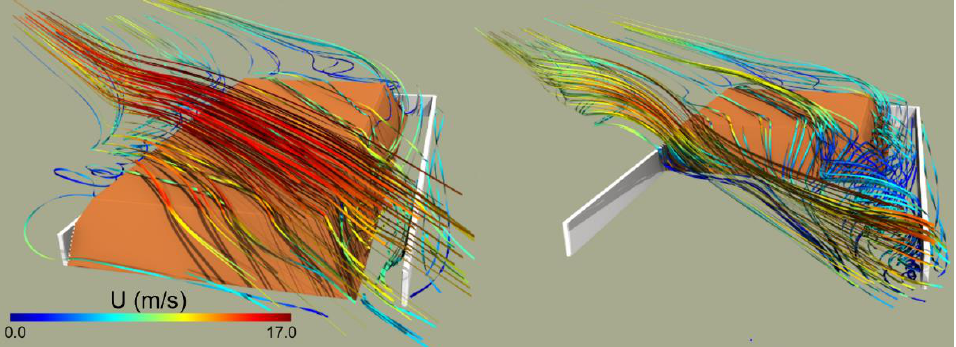
Figure 6. Streamlines over and around a high rectangular heap (HR, left plot) and a high square heap (HS, right plot) with enclosing walls and SE incoming wind.